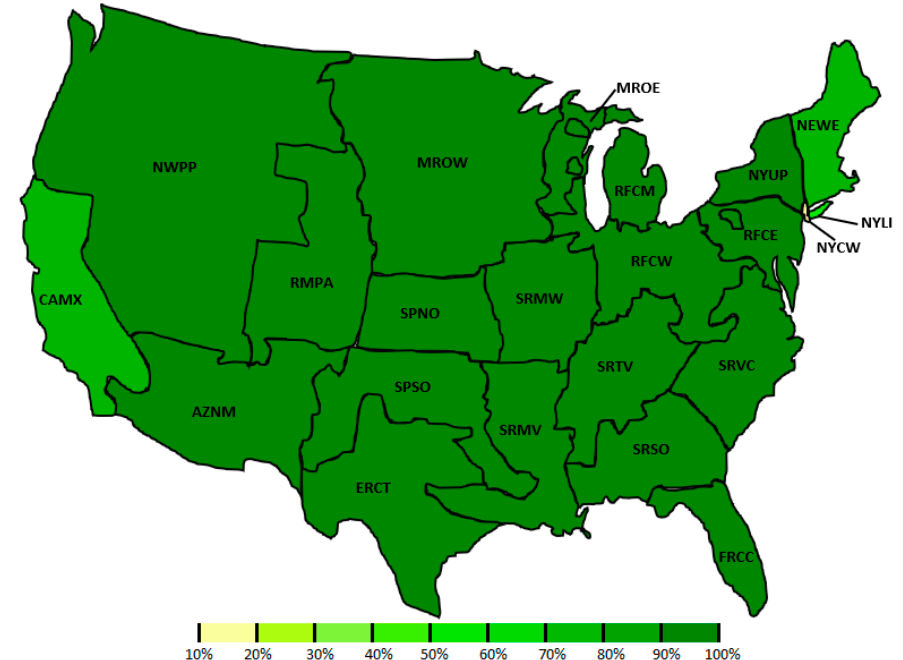
Figure 7. Percent reduction in SO 2 emissions from 20 MW of Reg A frequency regulation operating 24 hours a day for a year resulting from using the compensated generation natural gas plant instead of the BESS.